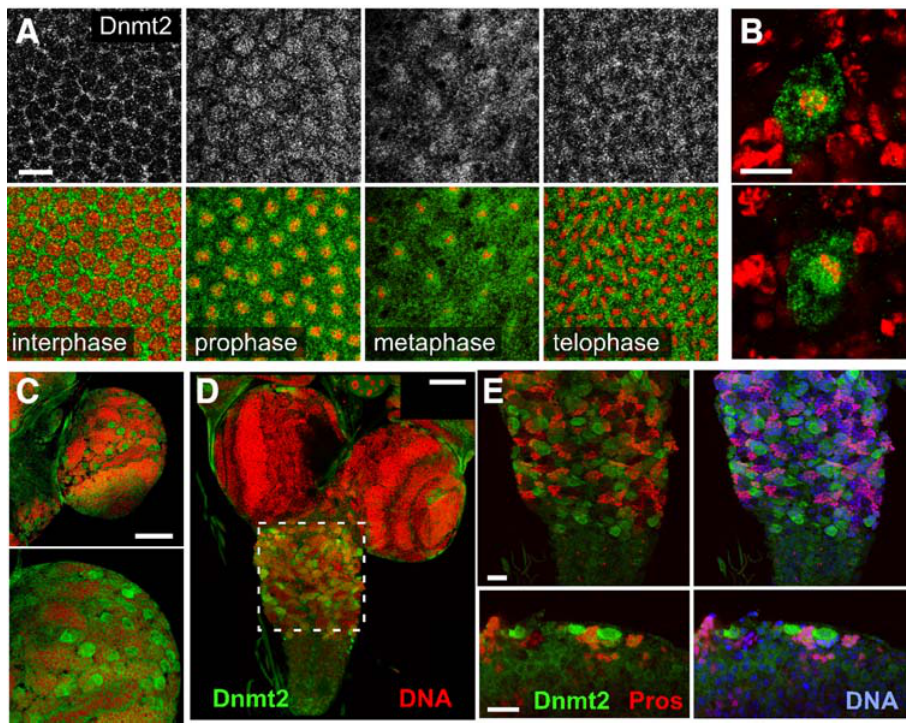
Figure 4. Dnmt2 localizes to mitotically active cells. (A) pGeno-Dnmt2-EGFP localizes to mitotic nuclei during prophase and localizes to midbody structures in telophase as visualized by anti-EGFP staining. Pictures show the distribution of Dnmt2-EGFP (gray, upper panel) and merged images (lower panel) with Dnmt2-EGFP in green and DNA in red. (B) Ectopic Dnmt2-EGFP localizes around metaphase chromosomes. Cell-type specific expression of UAS-Dnmt2-EGFP using asense-GAL4 causes Dnmt2 to localize to nuclear structures during mitosis. Ectopic protein localizes to prophase chromatin of CNS neuroblasts (upper panel) and aggregates densely around the mitotic metaphase plate (lower panel). (C) pGeno-Dnmt2- EGFP localizes to mitotic nuclei during larval development (upper panel). Frequently dividing optic lobe neuroblasts are enriched for Dnmt2-EGFP expression as visualized by anti-EGFP staining (lower panel). (D–E) Ventral ganglion neuroblasts express high levels of Dnmt2-EGFP, whereas ganglion mother cells (marked by Prospero, red, in E), which give rise to differentiated neurons and glia, do not express Dnmt2-EGFP. Scale bars: (A) 10 m m; (B) 10 m m; (C, D) 50 m m; (E, F) 20 m m; (G) 10 m m. (Fig. S1) suggesting that the Dnmt2 mojety targets the EGFP signal to mitotic chromatin.